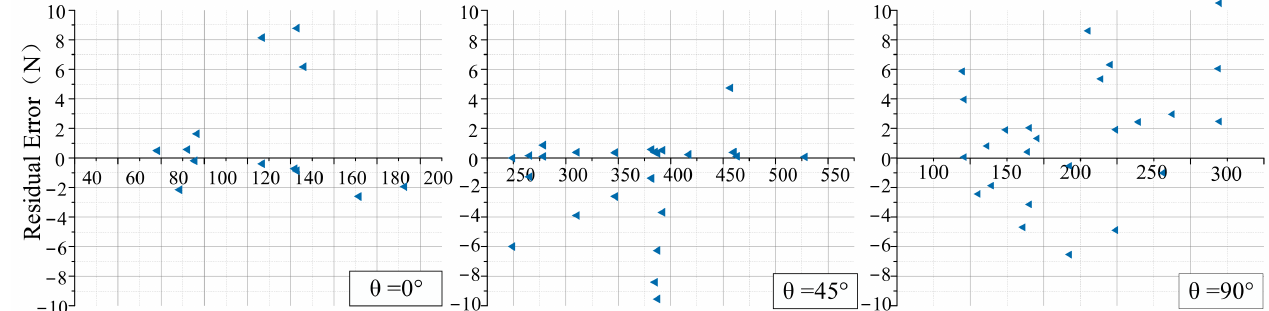
Figure 9. Residual distribution.